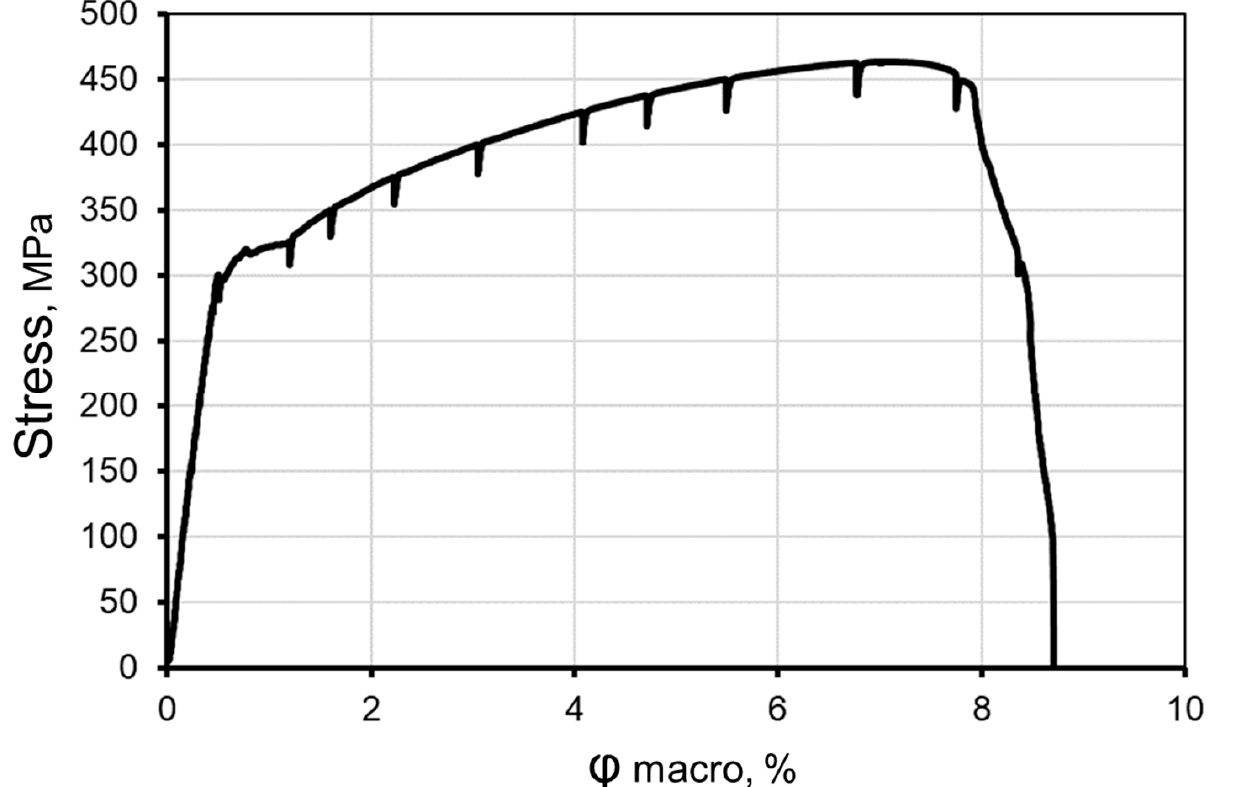
The tests yielded the stress–strain diagram shown in Figure A7. The diagram shows that the range of plastic deformation started at 300 MPa. The maximum tensile strength achieved was 462 Mpa, and the breakage of the specimen began at a stretch of 7.9%